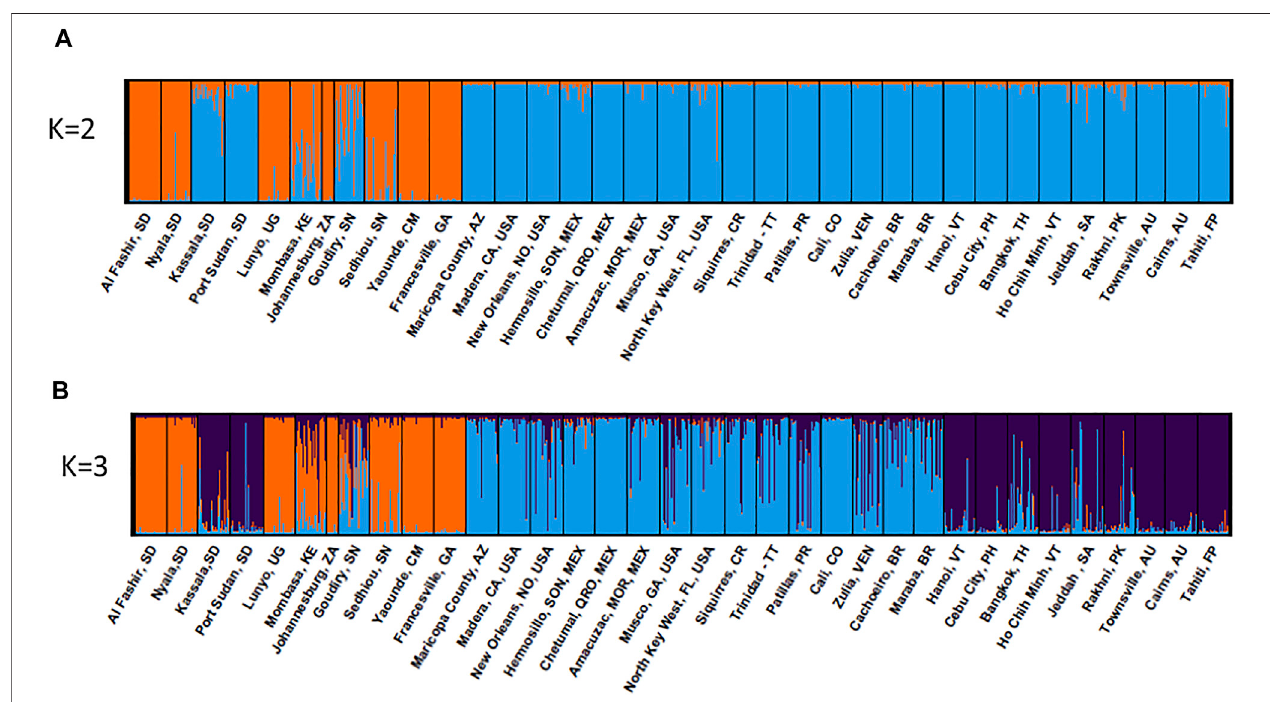
FIGURE 5 | Global genetic structure of Ae. aegypti populations. STRUCTURE bar plot indicating genetic groupings of fi ve continents (35 geographic locations) basedon12microsatelliteloci.Eachverticalbarrepresentsanindividual.Theheightofeachbarrepresentstheprobabilityofassignmenttoeachof (A) K=2and (B) K= 3 clusters. The optimal number of clusters was determined using the Delta K method as K = 2. Each cluster is indicated by different colour: Aaa: orange and Aaf: blue.